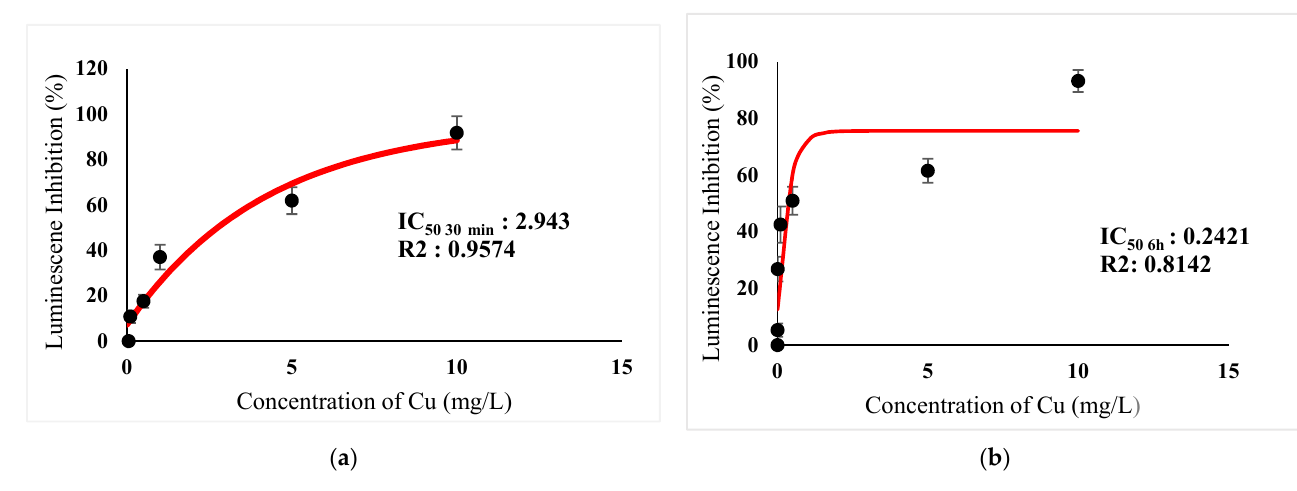
Figure 4. ( a ) Acute and ( b ) Chronic toxicity of Cu 2+ on luminescence inhibition of Photobacterium sp.NAA-MIE. Data represent mean ± SD, n = 3.